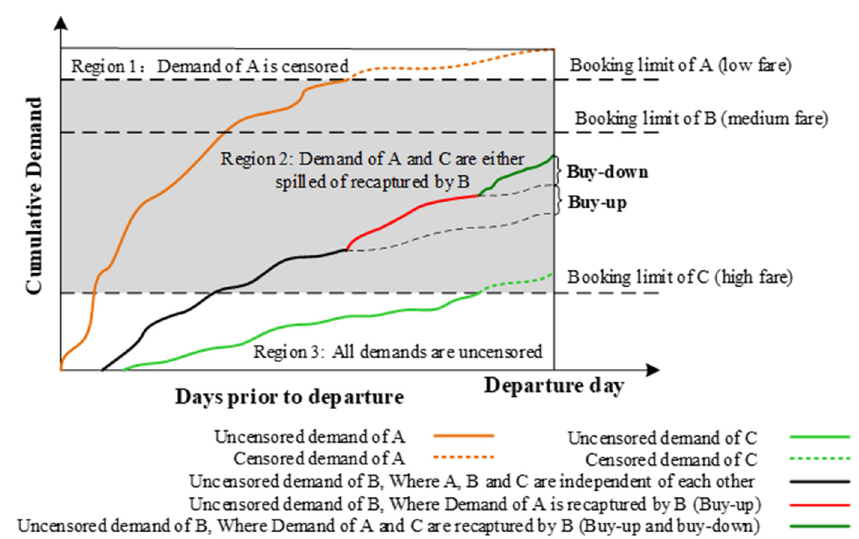
Figure 1. Booking curves for given streams of arrivals.